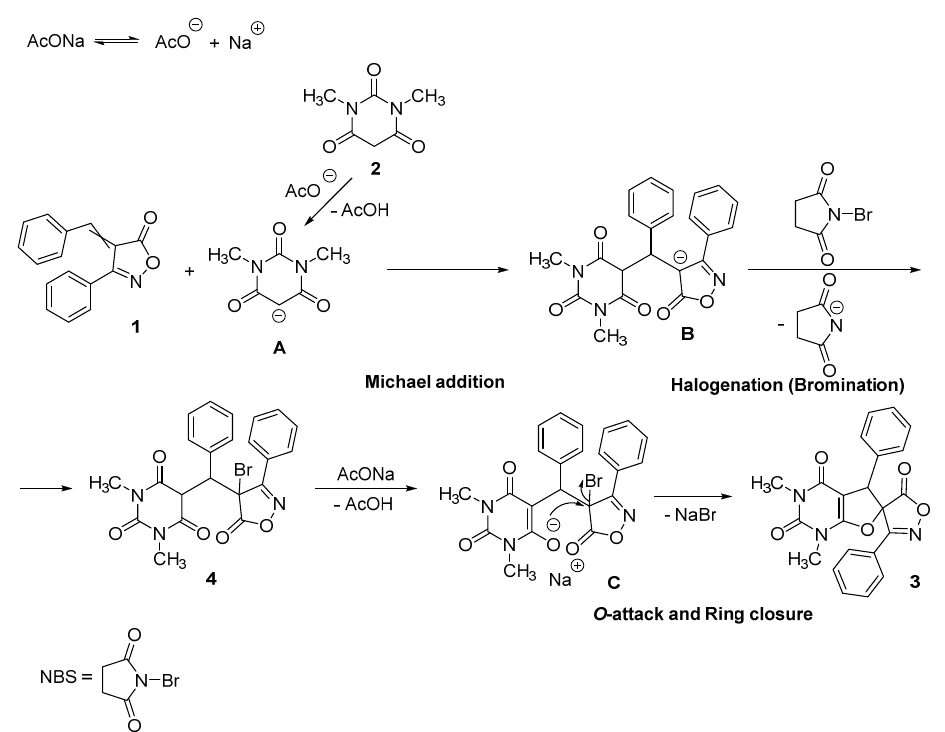
Scheme 2. Mechanism of 4-benzylidene-3-phenylisoxazol-5(4 H )-one ( 1 ) and 1,3-dimethylbarbituric acid ( 2 ) MHIRC transformation into spiro[furo[2,3- d ]pyrimidine ( 3